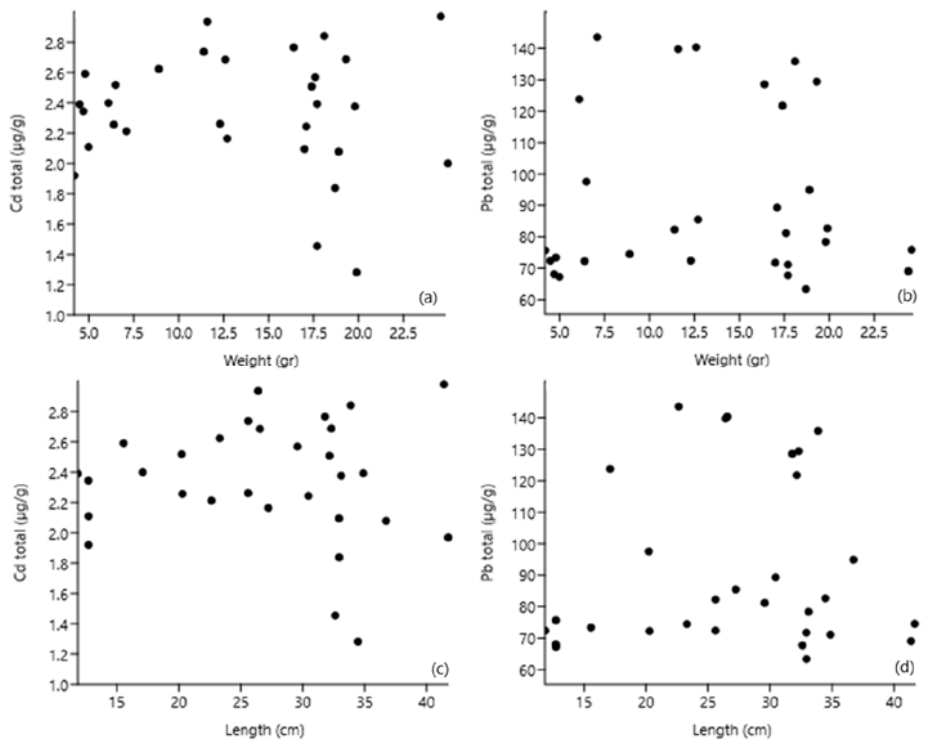
Fig. 5: Correlation between eel weight and total Cd (a), eel weight and total Pb (b), eel length and total Cd (c), and total eel and Pb length (d)